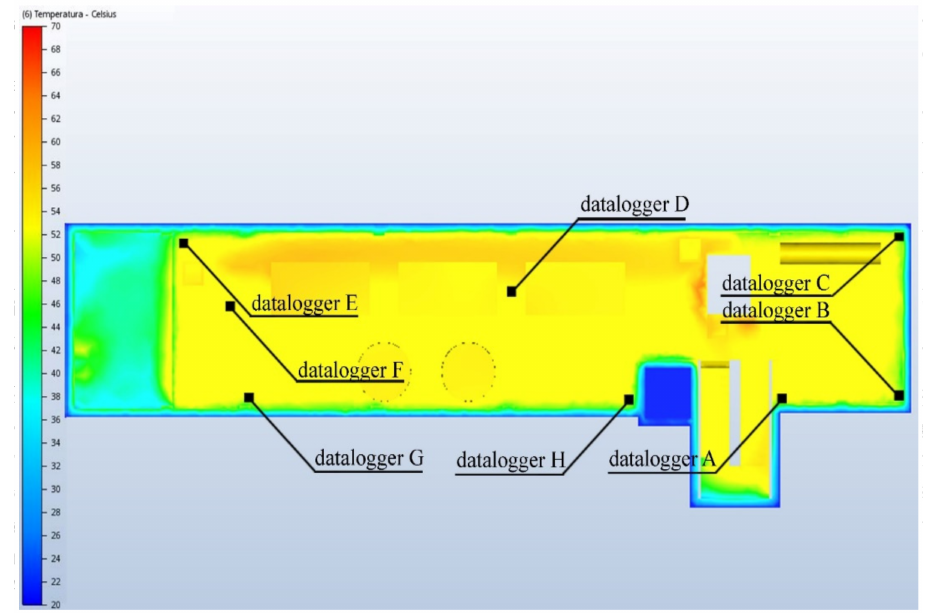
Figure 9. Positions of data-loggers and simulated air temperature distribution within the CFD model.